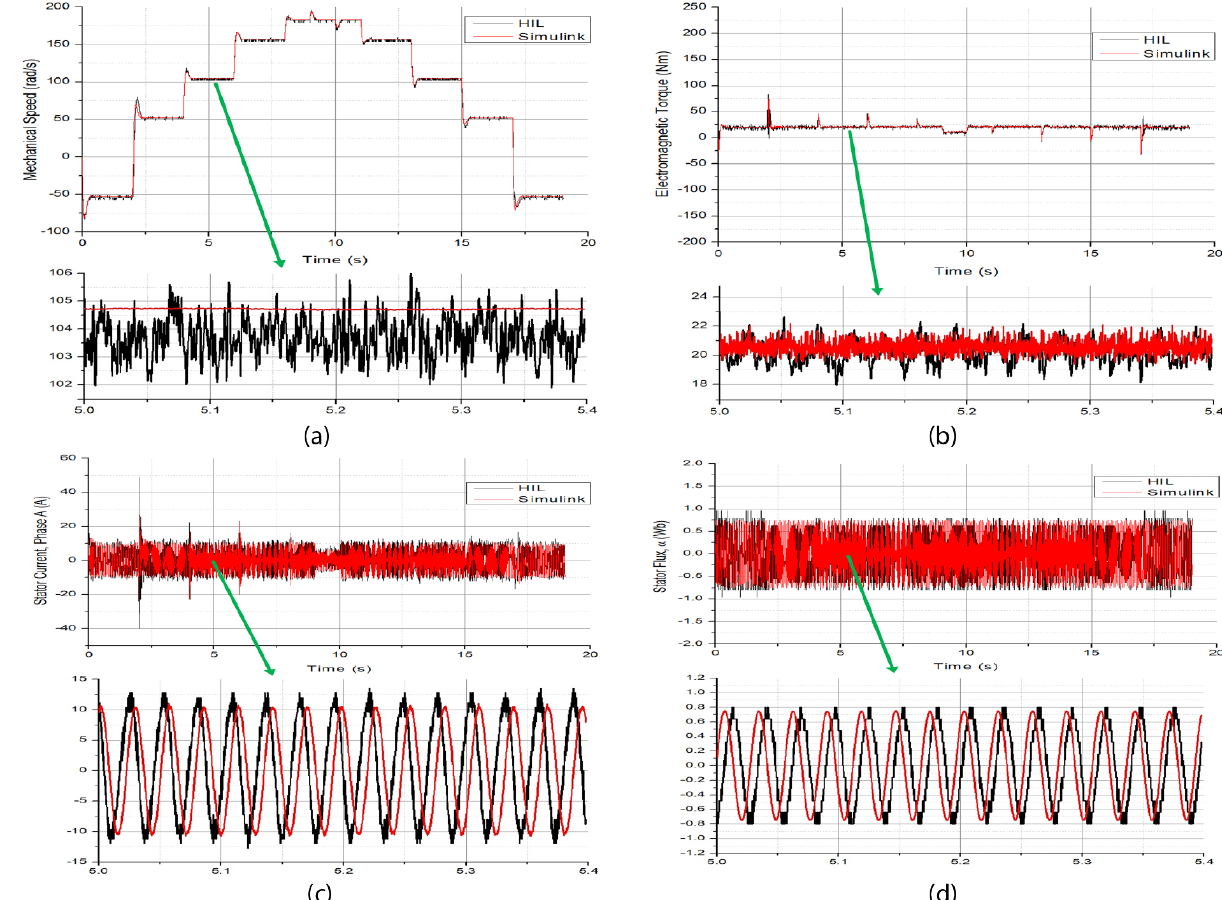
Figure 12. Numerical and practical results of the FTC variable speed controller: ( a ) speed; ( b ) torque; ( c ) stator current; and ( d ) stator